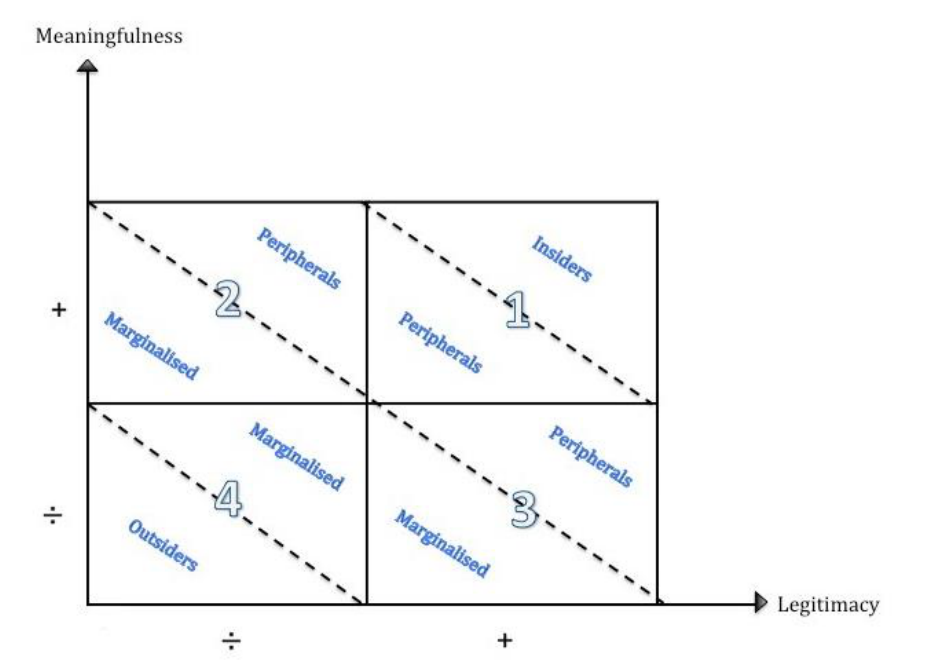
Figure 2. Students’ positions of participation in